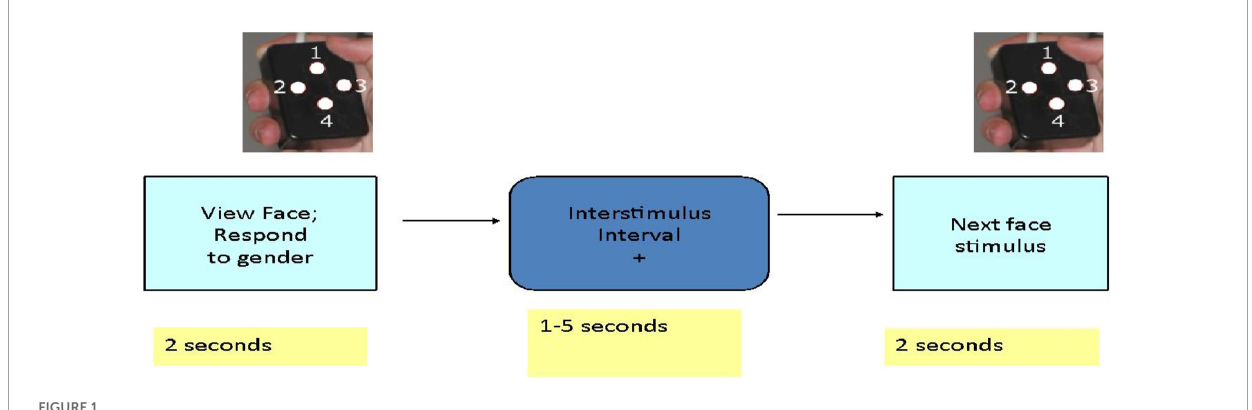
FIGURE1 Schematic view of emotional faces task.